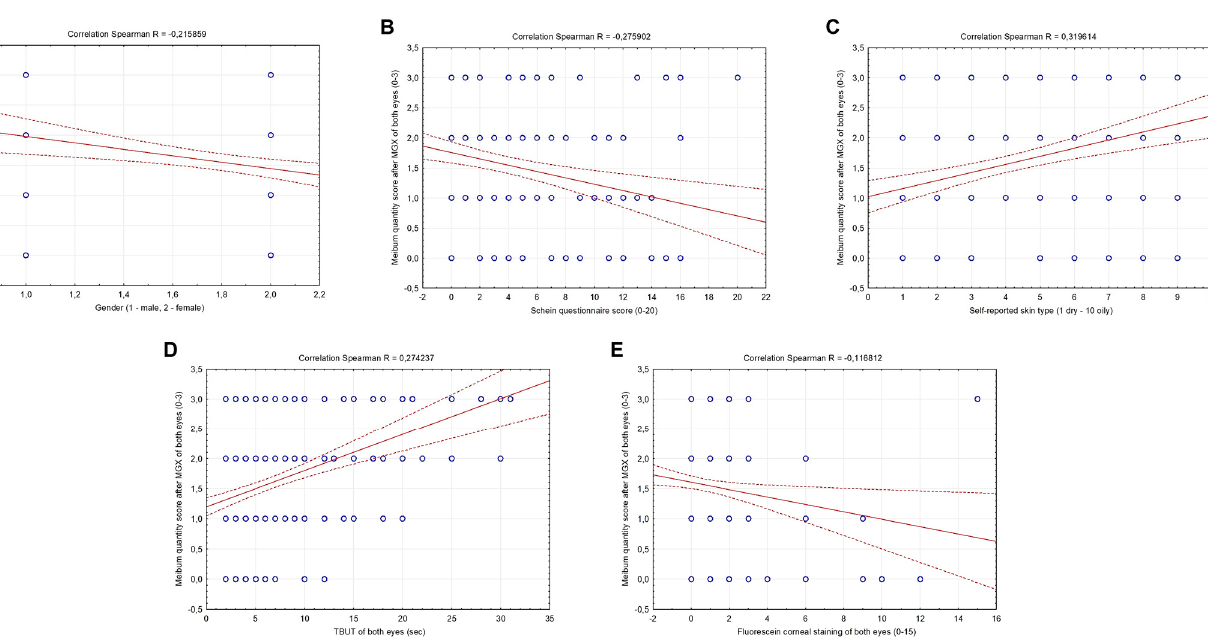
Figure 1. Correlations between the meibum quantity score after MGX, gender ( A ), Schein question- naire score ( B ), skin type ( C ), TBUT ( D ) and fluorescein corneal staining ( E ) of both eyes in all subjects included in the study.